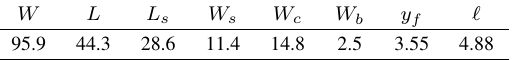
TABLE 5. Optimized Geometry (in mm) for the Frequency Reconfigurable E-shaped Patch [26]